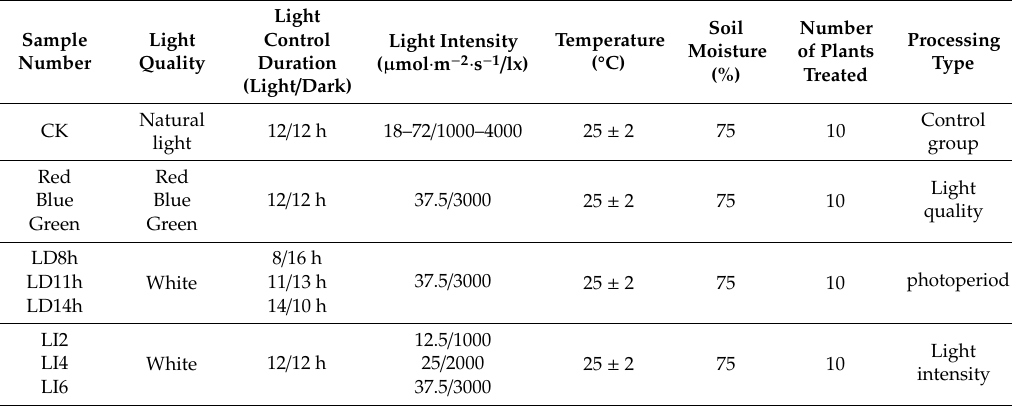
Table 1. Lithocarpus polystachyus culture conditions during light